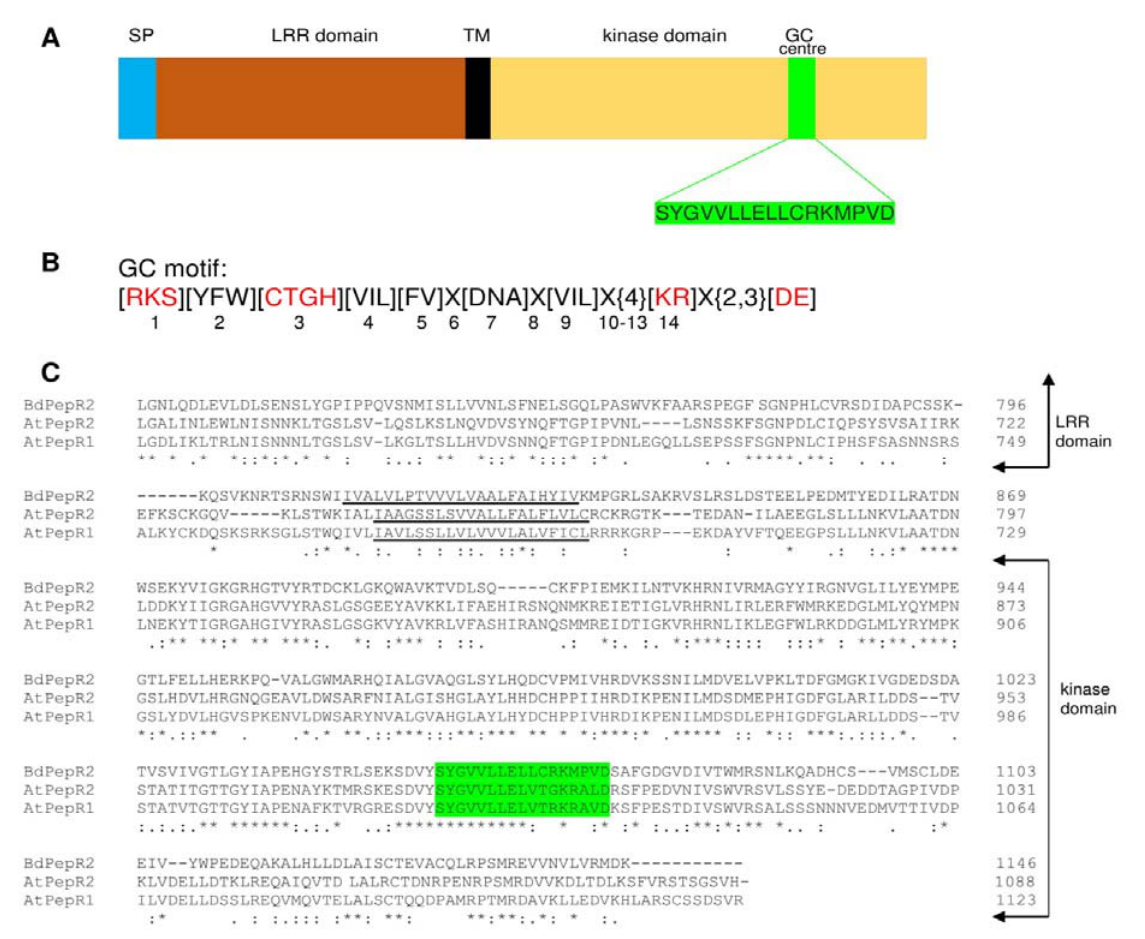
Figure 1. Structural features of GC catalytic domain of BdPepR2. ( A ) Representation of domain organization of BdPepR2 containing a signal peptide (SP), leucine-rich repeats (LLRs), transmembrane domain (TM), and GC center embedded in kinase domain. ( B ) Fourteen amino acid long original search motif; red amino acids are functionally assigned residues of the catalytic center. Residue in position 1 can form hydrogen bond with purine; residue in position 3 confers substrate specificity; residue in position 14 stabilizes transition state from GTP to cGMP; amino acid [D or E] at 2–3 residue downstream from position 14 participates in Mg 2+ /Mn 2+ -binding. ( C ) Amino acid sequence alignment of BdPepR2 (XP_003571653.1), AtPepR1 (OAP14914.1), and AtPepR2 (OAP12577.1) using the Clustal Omega. Predicted protein domains are indicated on the right side, TM is underlined, GC motif is highlighted in green. An * (asterisk) indicates positions that have a single, fully conserved residue. A: (colon) indicates conservation between groups of strongly similar properties. A. (period) indicates conservation between groups of weakly similar properties.